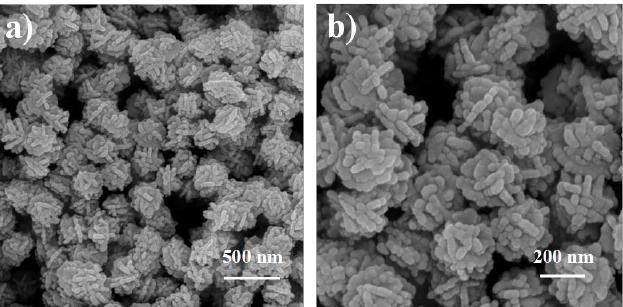
Figure 1. Scanning electron microscope (SEM) images of the ball-like Ag nanorod aggregates.